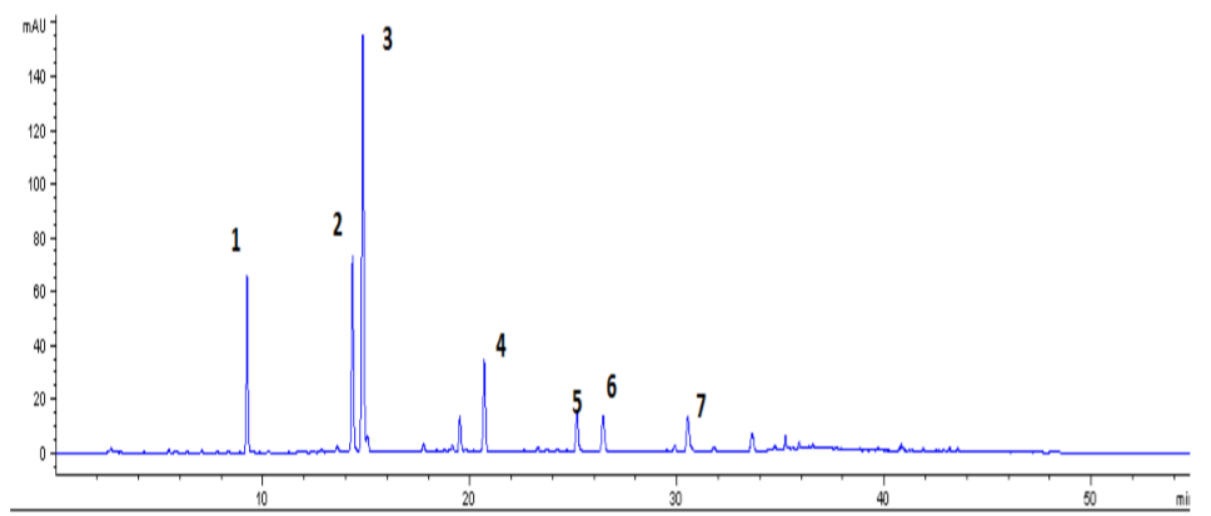
Figure 1. HPLC profile of coffee silver skin at 330 nm of phenolic acids in extract (MetOH:H 2 O 70:30). Identified peaks are: caftaric acid ( 1 ), chlorogenic acid ( 2 ), caffeic acid ( 3 ), ferulic acid ( 4 ), chlorogenic acid isomers ( 5 – 7 ).